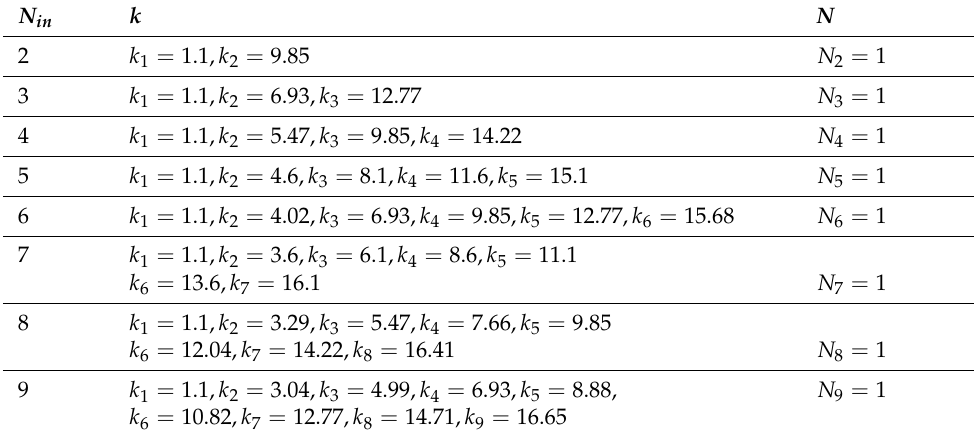
Table 3. Values of the updated shape parameters k and of the decision variables ( N in and N ). N